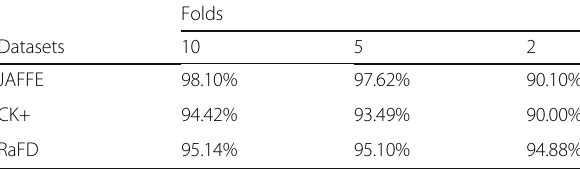
Table 3 Proposed accuracy method using K-fold method Folds